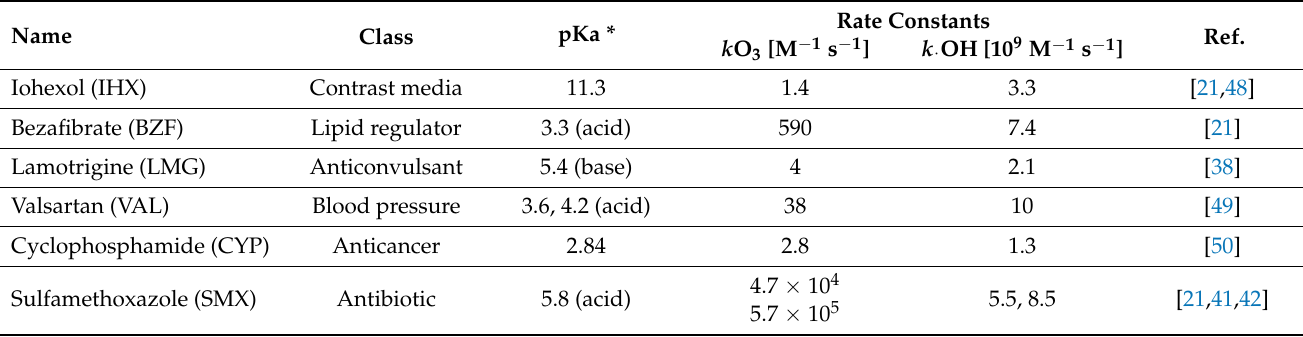
Table 8. Properties of the pharmaceutical compounds used in this